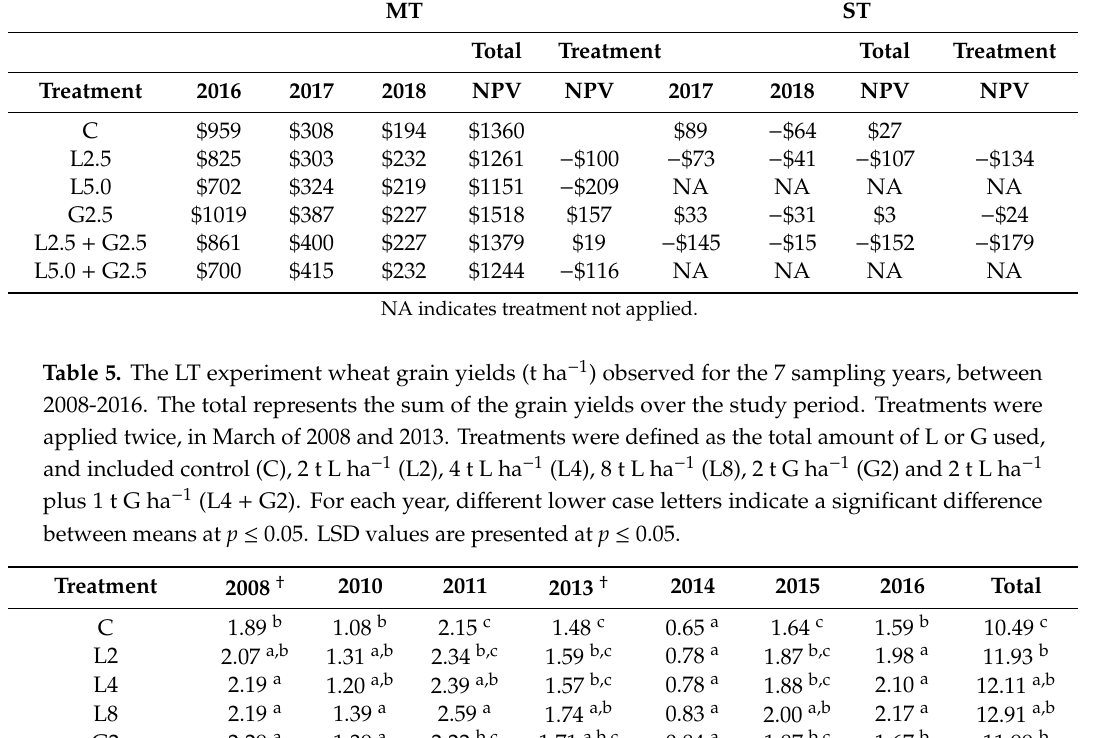
Table 4. Profit ($ ha − 1 ) is calculated for canola in 2016, wheat in 2017, and barley in 2018, at the MT (3 growing seasons, 2017–2018), and the ST (2 growing seasons, 2016–2018) experiments. The total net present value (NPV) was calculated over the study period. Treatment NPV is the total NPV for the treatment minus total NPV of the control. Treatments were applied once at the MT experiment in July 2015, and at the ST experiment in March of 2017. MT ST Total Treatment Total Treatment